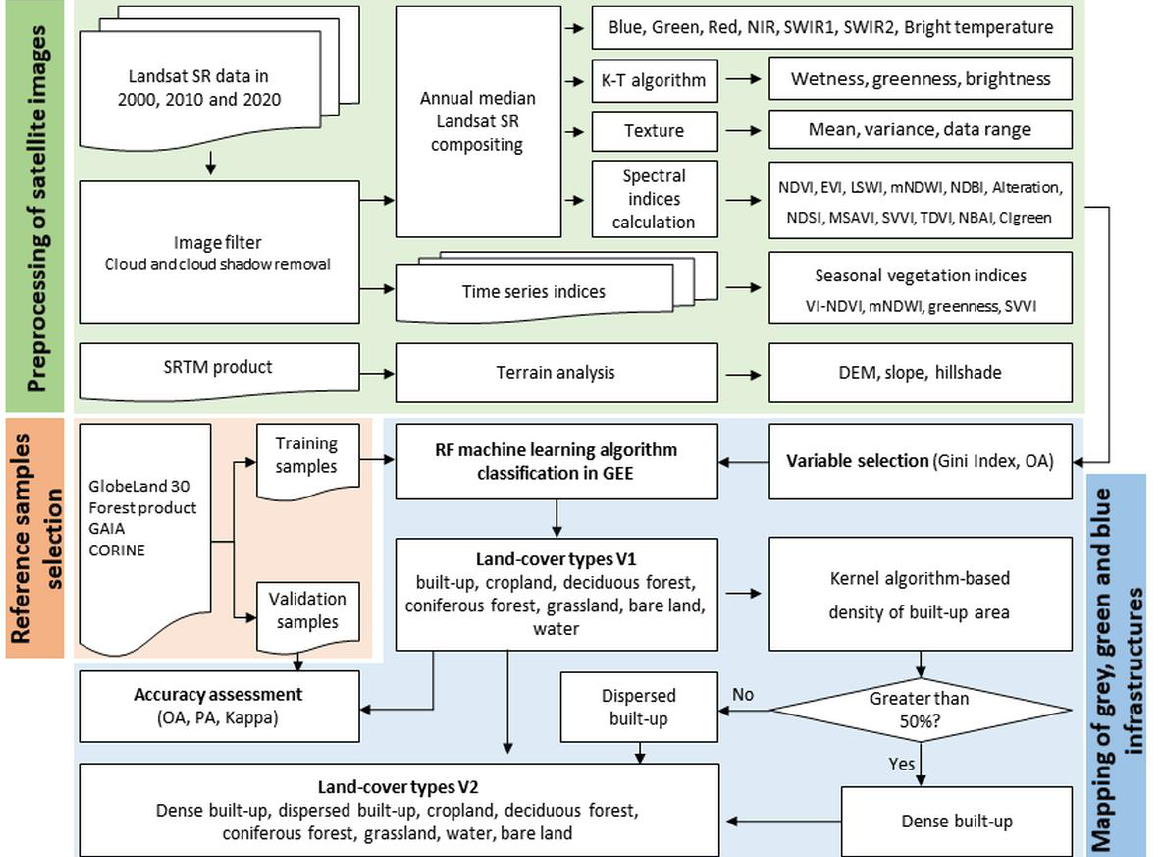
Figure 2. Workflow for mapping of grey, green and blue infrastructures. 3.3.1. Preprocessing of Satellite Images As GEE provides free access to all Landsat surface reflectance images, we used the Landsat 5 TM surface reflectance Tier 2 product from GEE for 2000 and 2010 LC mapping. For 2020 we opted for the Landsat 8 OLI/TIRS surface reflectance Tier 2 product. All the cloud and cloud shadow pixels were removed using C implementation of the Function of Mask (CF Mask) algorithm [26]. To test which variable was important for mapping urban LC categories, we prepared a total of 32 variables. The specific variables are as follows: 1.